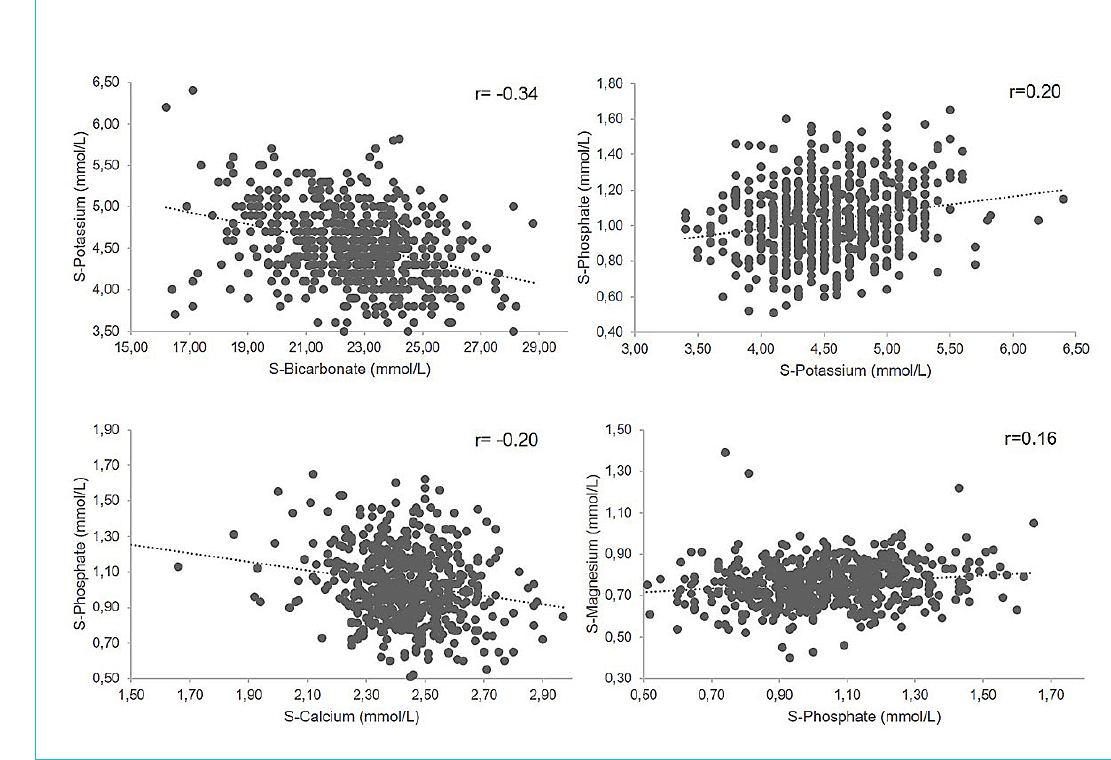
Figure 3: Significant correlations between serum electrolyte